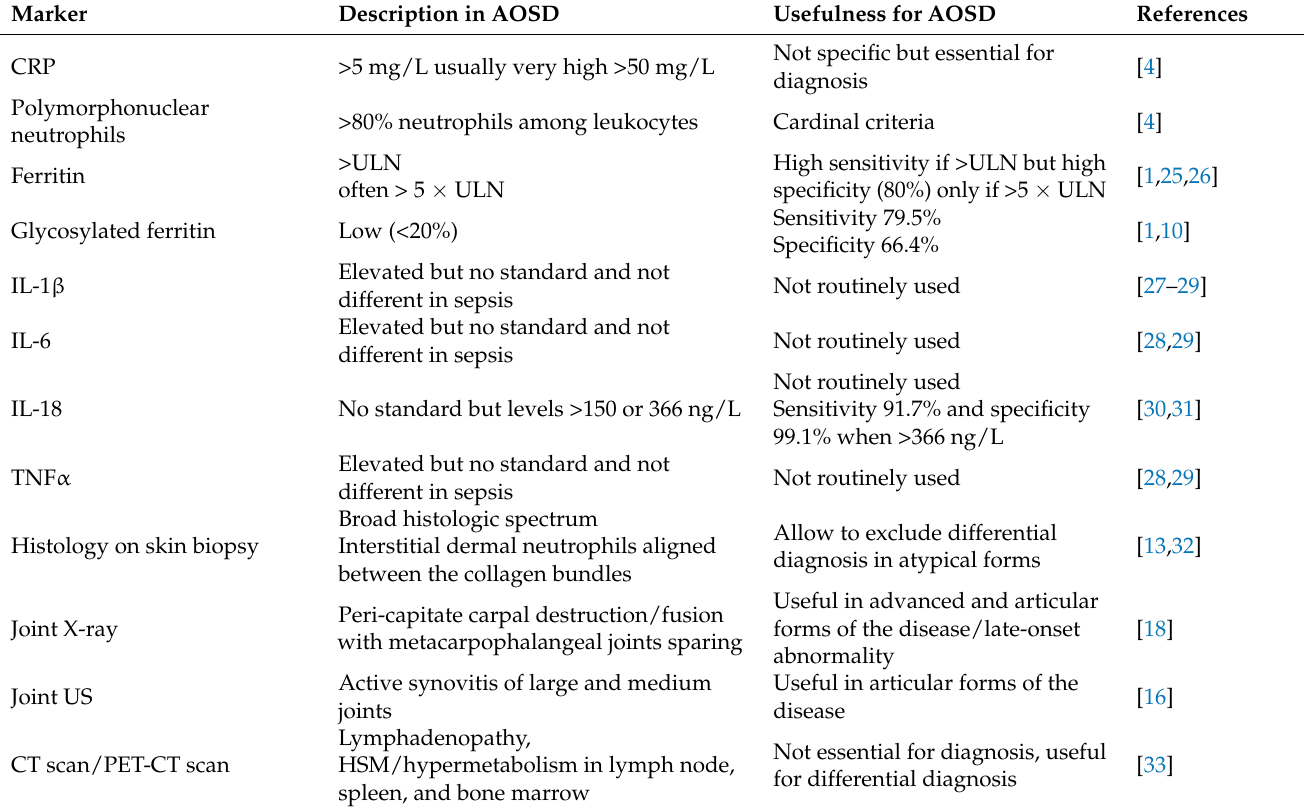
Table 1. The main tests used for the diagnosis of adult-onset Still’s disease